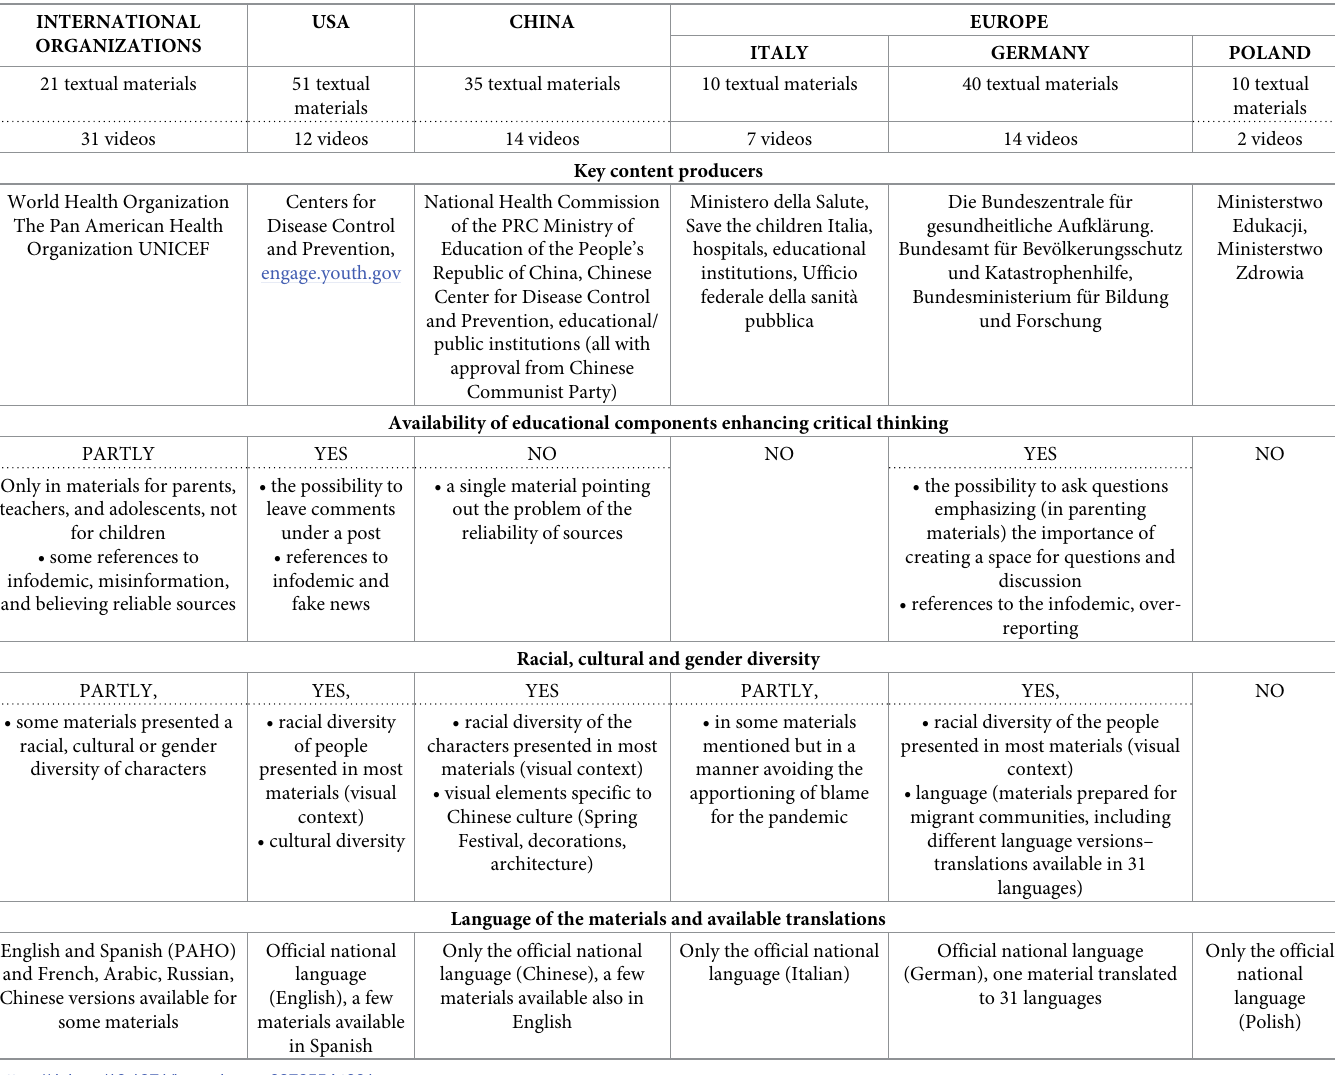
Table 1. Educational materials about the pandemic designed for children, adolescents published by American, Chinese, Italian, German, and Polish national insti- tutions and international organizations included in the analysis. INTERNATIONAL